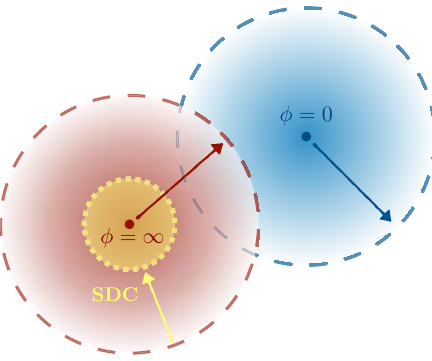
Figure 3 . Sketch of a moduli space with different local patches describing the different regimes of validity of an effective theory. For simplicity, we only draw two singularities, assuming one of them at infinite distance ( φ = ) and the other one at finite distance ( φ = 0). The effective field theory is ∞ valid at a finite region around the singularity. When going away (red or blue arrow), corrections will become important and eventually has to be replaced by another effective description. Quantifying these corrections defines the radius of validity (dashed circles) of the EFTs. Contrary, the SDC gives information on how close we can go to the singular point (yellow arrow). Even if in this limit the metric at leading order is well described by 1 /φ 2 and corrections are negligible, there is an additional infinite tower of particles which will yield an exponential drop-off of the energy cut-off. This sets a new boundary (yellow dotted circle) and a corresponding area where the EFT breaks down by quantum gravity effects (yellow